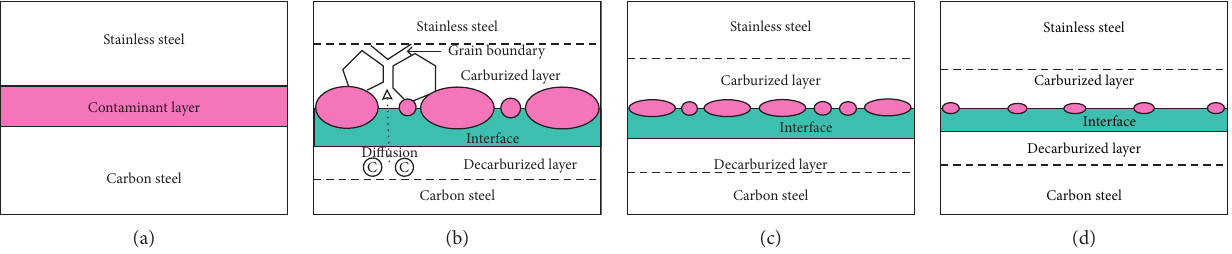
Figure 1: The bonding mechanism of hot rolling carbon steel/stainless steel. (a) Initial state. (b) Diffusion process of carbon atom. (c) Contaminants refinement process. (d) Further refinement of contaminants.